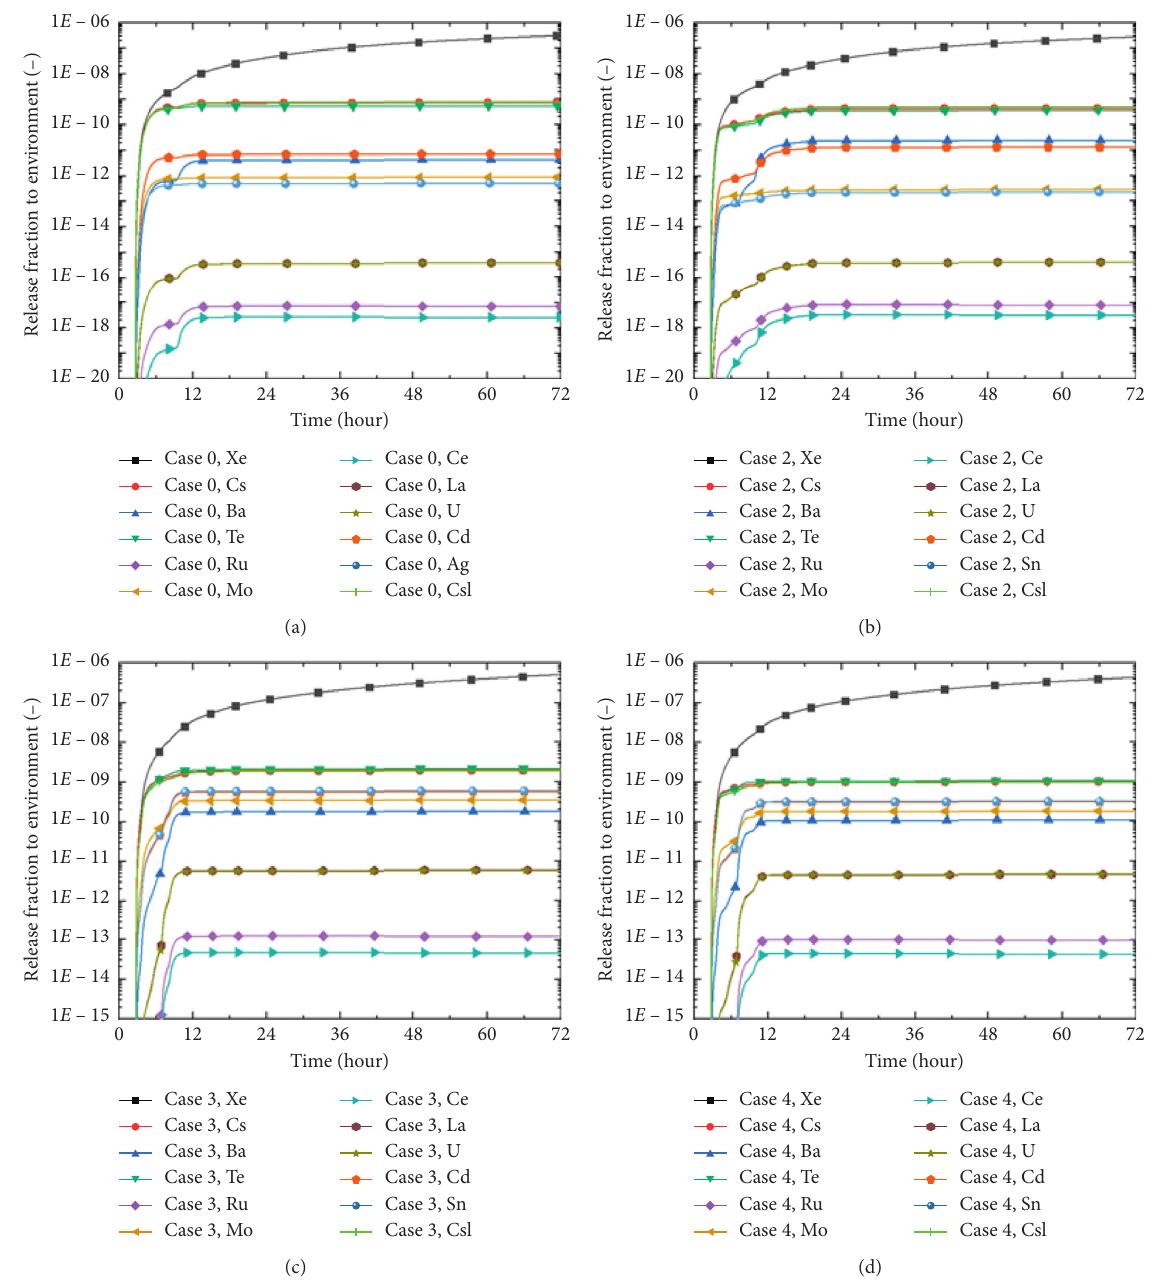
Figure 11: Release fractions to the environment: (a) case 0, (b) case 2, (c) case 3, and (d) case